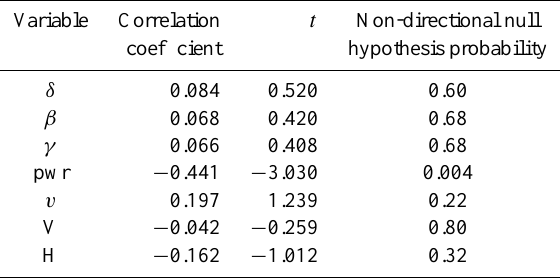
Table 3. Same as Table 2 but with the three > 2 σ outlier events removed from the dataset.